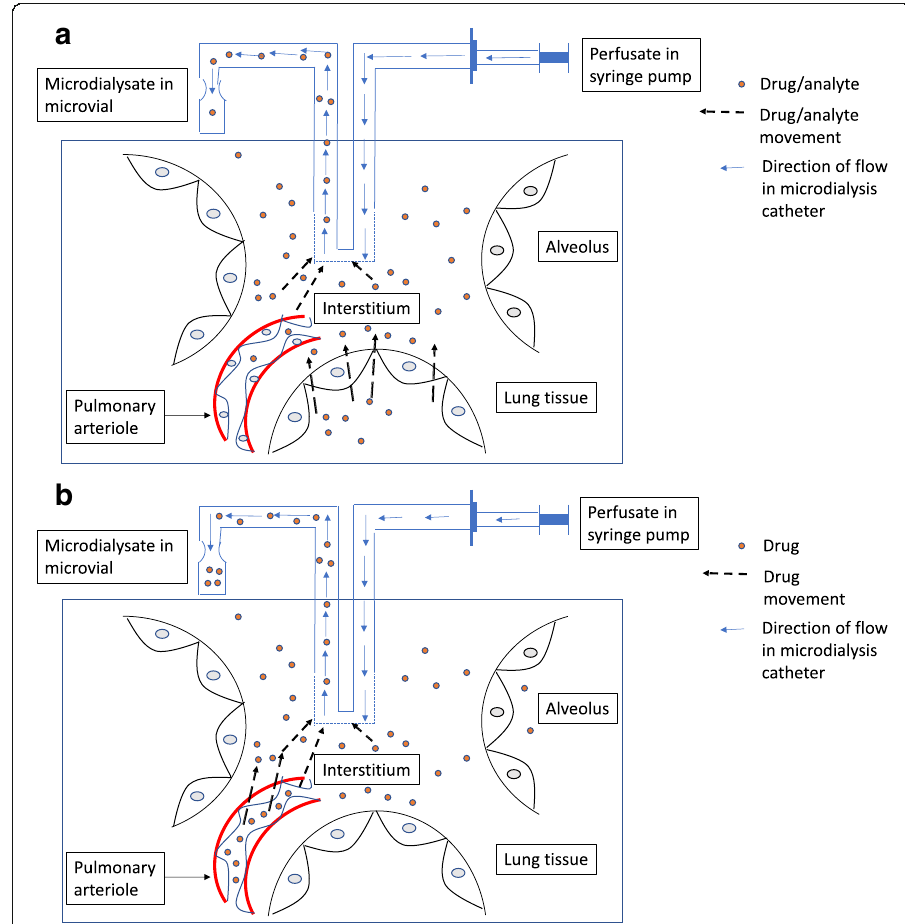
Fig. 3 Schematic diagram demonstrating the principle of lung microdialysis. The unidirectional perfusate flow provides a concentration gradient for diffusion of analytes across a semi-permeable membrane placed in the lung interstitium. The dialysate is then collected in microvials for analysis. a Principles of lung microdialysis with nebulised antibiotics — showing higher antibiotic concentration in the alveoli. b Principles of lung microdialysis with intravenous antibiotics — showing higher antibiotic concentration in the pulmonary